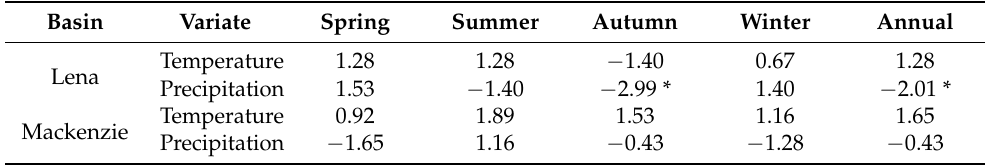
Figure 2. Variations in the annual and seasonal temperatures and precipitations in the MRB and LRB during 2003–2016. ( a ) annual temperature; ( b ) seasonal temperature; ( c ) annual precipitation; ( d ) seasonal precipitation. Table 1. The results of the TFPW-MK test for temperature and precipitation in Lena and Mackenzie. Values exceeding 1.96 represent upward significant trends, whereas those less than 1.96 represent decreasing trends at α < 0.05. Basin